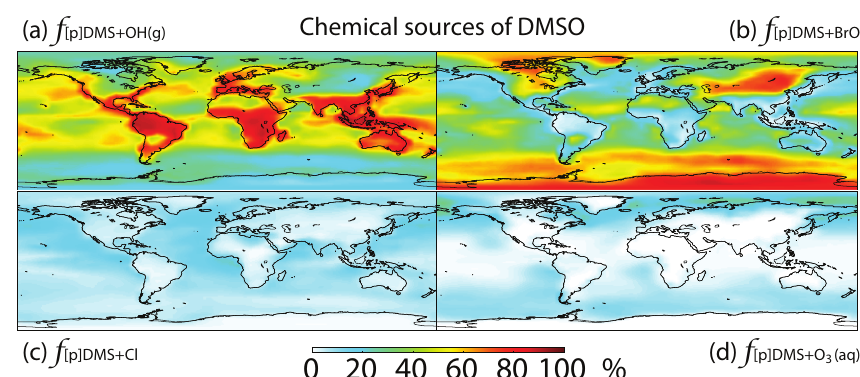
Figure 4. Global tropospheric distribution of annual-mean percentage of DMSO produced via (a) DMS + OH ( g ) ( f [ p ] DMS + OH (b) DMS + BrO ( f [ p ] DMS + BrO ), (c) DMS + Cl ( f [ p ] DMS + Cl ) and (d) DMS + O 3 ( aq ) ( f [ p ] DMS + O